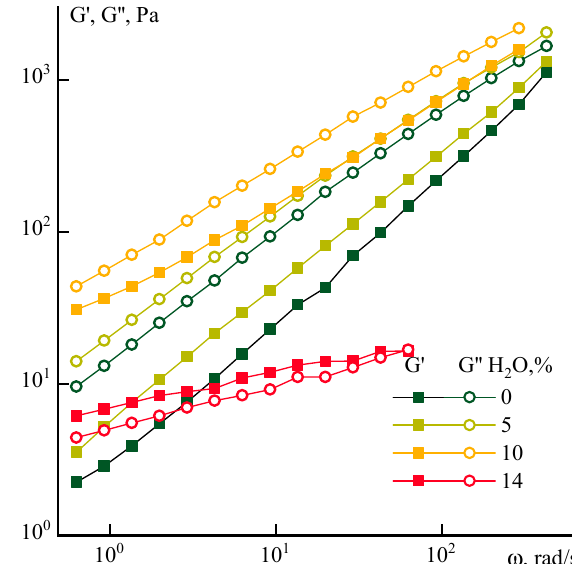
Figure 9. Frequency dependences of dynamic moduli of PANI-O solutions containing different content water.